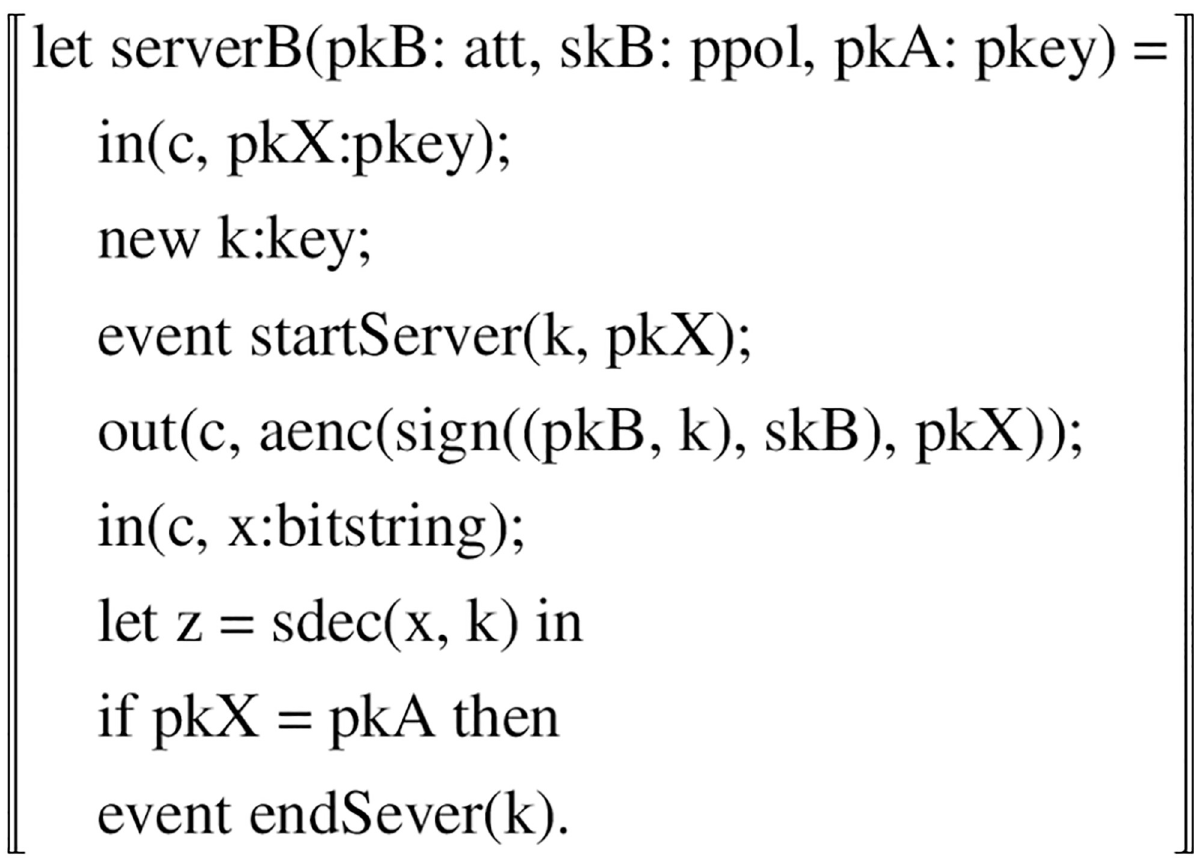
Fig 15. Sever’s process.